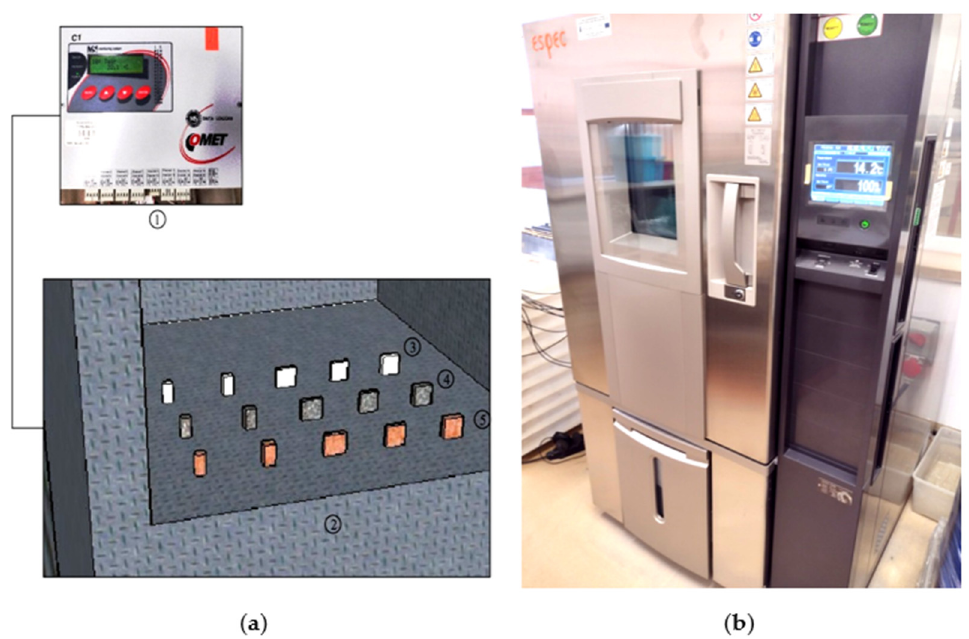
Figure 2. ( a ) Layout of the test specimens and data logger during testing; 1—data logger; 2—test chamber interior; 3—specimens of pure PCM; 4—specimens of PCM with coke recyclate; 5—specimens with PCM and a copper/polymer matrix; ( b ) Espec climate test chamber.